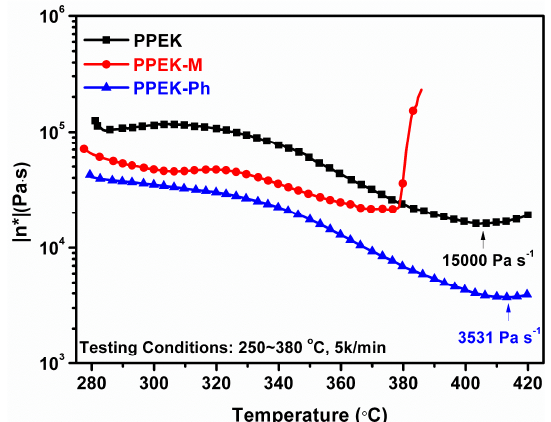
Figure 7. The rheological curves of the PPEKs at an oscillator frequency of 1 Hz from 280 to 420 ◦ C.